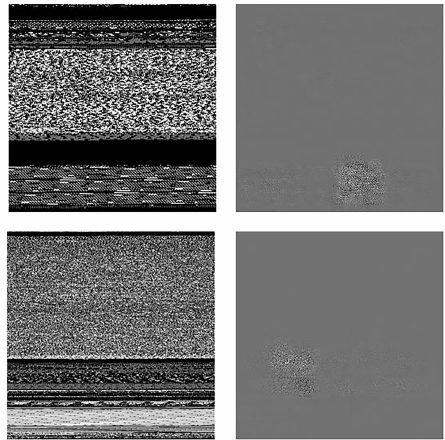
Figure 7. Gradient visualization of the malware image. Left column indicates the original malware images, and the right column indicates the corresponding